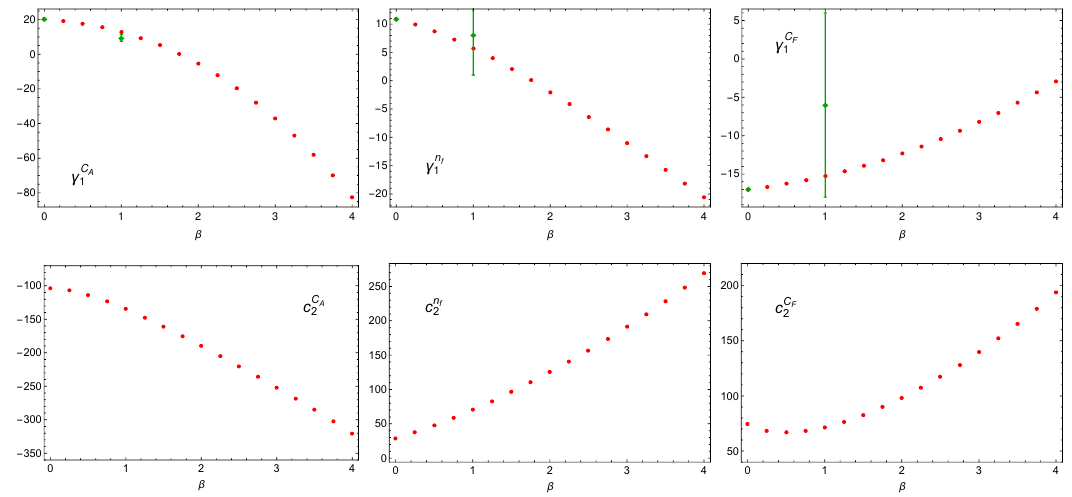
Figure 5. Two-loop anomalous dimensions and (cid:12)nite term of the renormalised soft function for the soft-drop jet groomer. Red dots indicate values calculated with SoftSERVE and the green diamonds show the numbers from